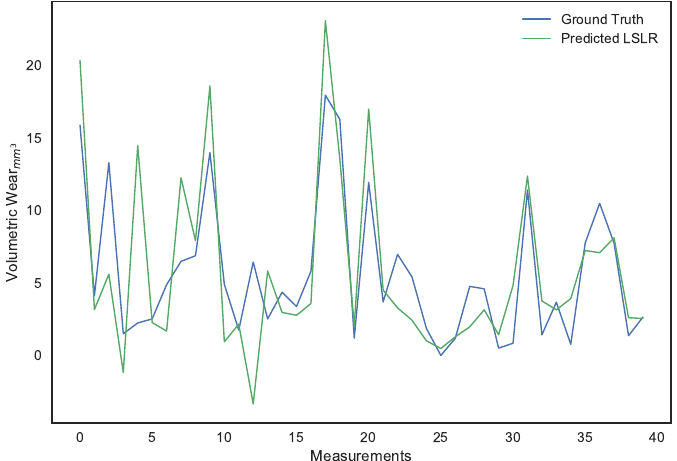
Figure 11. Surface wear prediction on the validation set using least squares Linear Regression.